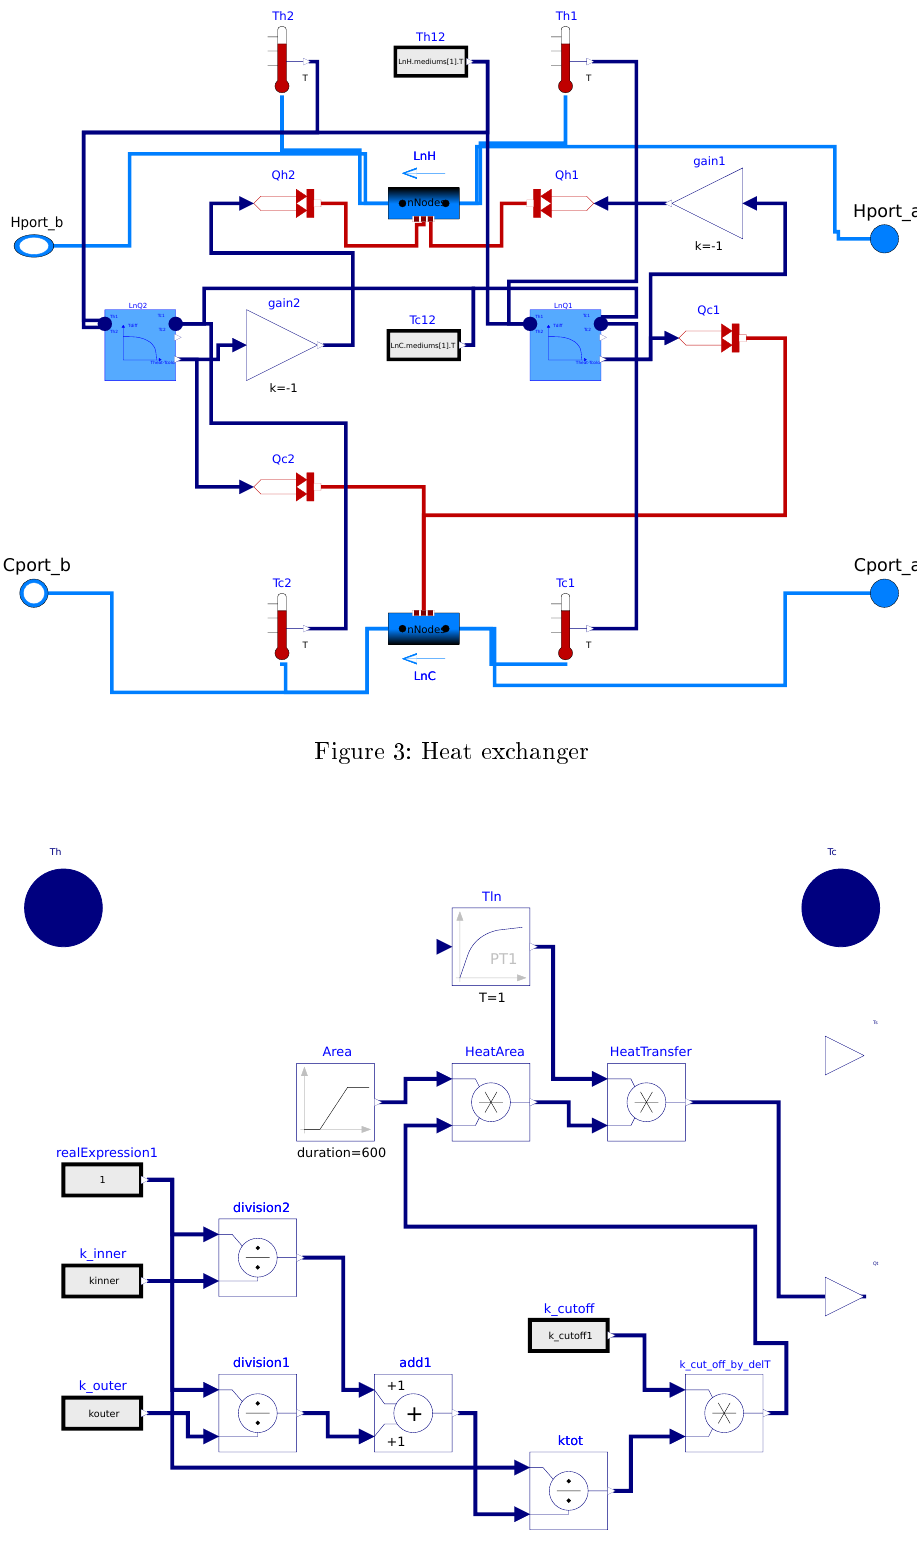
Figure 4: Heat transfer calculation